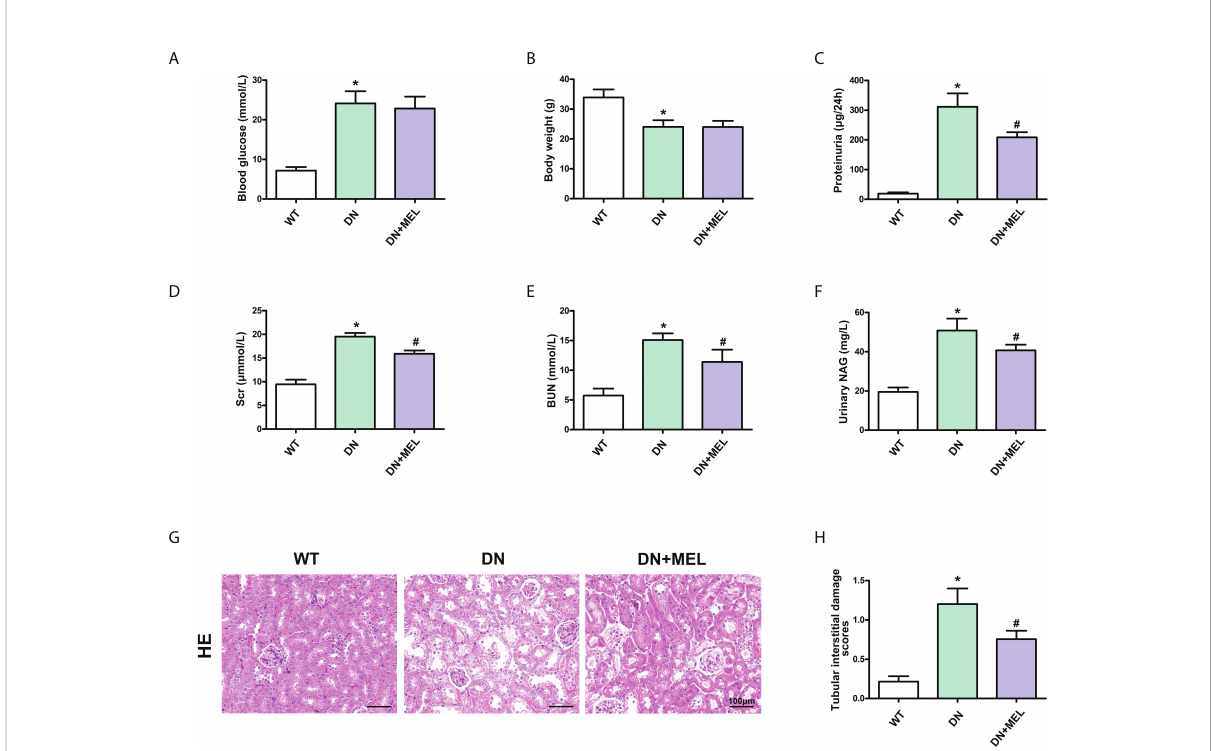
FIGURE 1 The effects of melatonin on biochemical indices and renal pathological changes in the kidneys of DN mice. The blood glucose (A) , body weight (B) , proteinuria (C) , serum creatinine (D) , BUN (E) , and urinary NAG levels (F) in different groups of mice. HE staining of renal paraf fi n tissue in different groups (G) . Tubular injury as assessed by tubular interstitial damage scores (H) . The values are the mean ± SD. n = 6/group. *p < 0.05 compared with the control group; # p < 0.05 compared with the DN